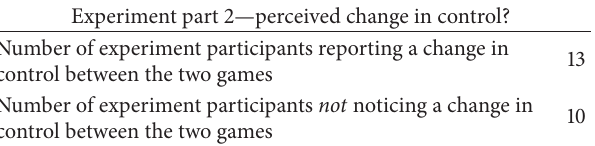
Table 7: Numbers of experiment participants reporting a change in control between the two versions of the game after part 1 in the experiment.